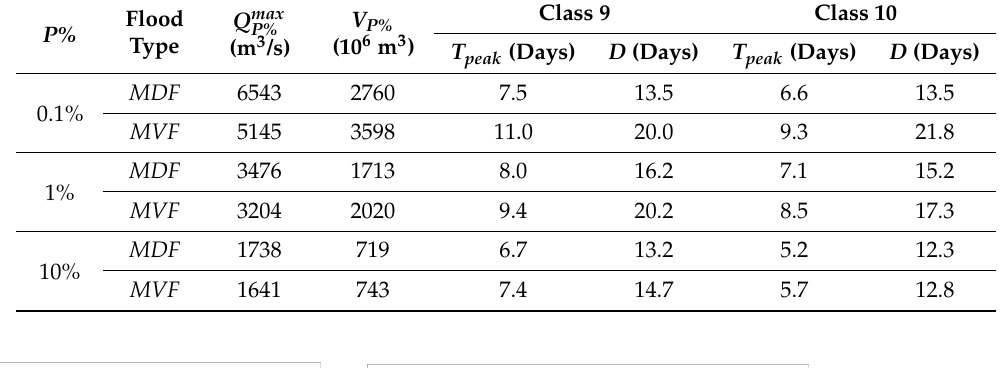
Table 8. Parameters of the design floods at Rădăuți -Prut.